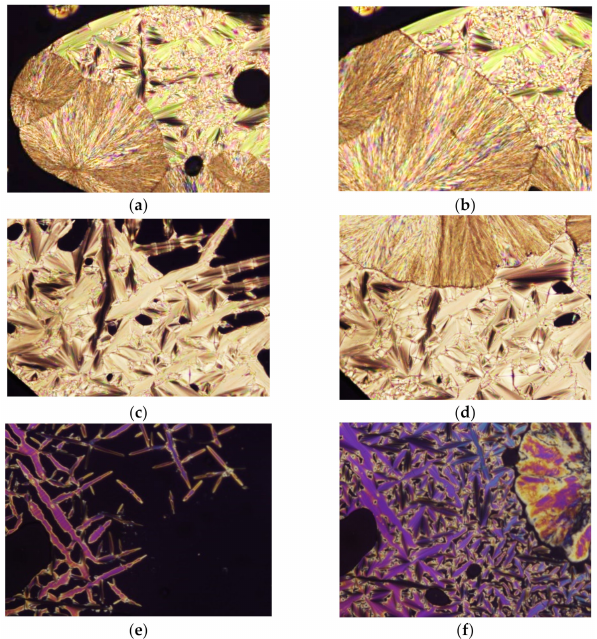
Figure 5. Polarized optical microscope (POM) pictures for mesogenic lanthanide complexes: 3b at 156 ◦ C ( a ) and at 150 ◦ C ( b ); 4b at 150 ◦ C ( c ) and at 145 ◦ C ( d ); 5b at 155 ◦ C ( e ) and at 150 ◦ C ( f